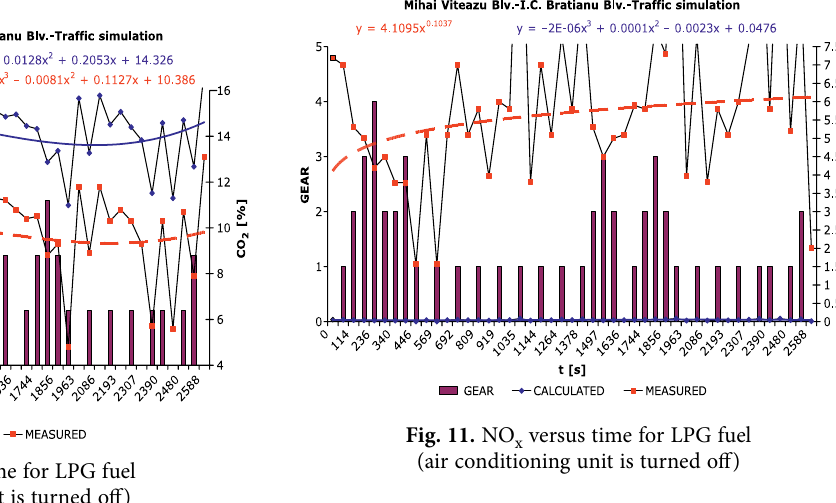
Fig. 9. CO 2 versus time for LPG fuel (air conditioning unit is turned off)